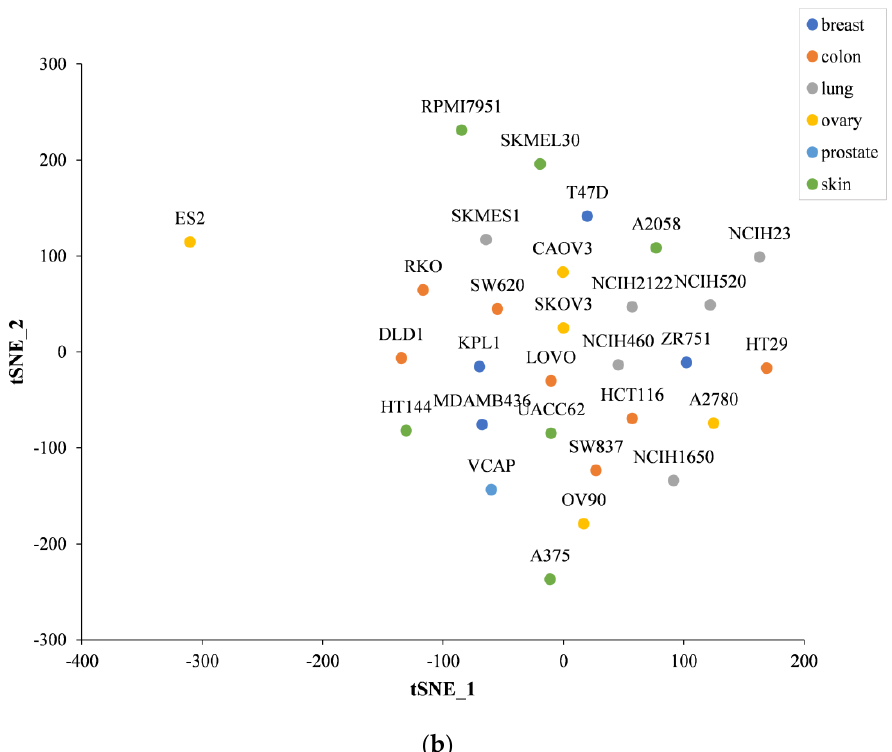
Figure 4. Different cell lines are subjected to t − SNE analysis to visualize the results. High − dimensional cell line vector representations are projected into 2D space with the first two t − SNE components. ( a ) Different colors indicate clusters per cell line assigned by the density − based spatial clustering of applications with noise (DBSCAN) clustering algorithm. ( b ) Different colors indicate different tissues of each cell line.